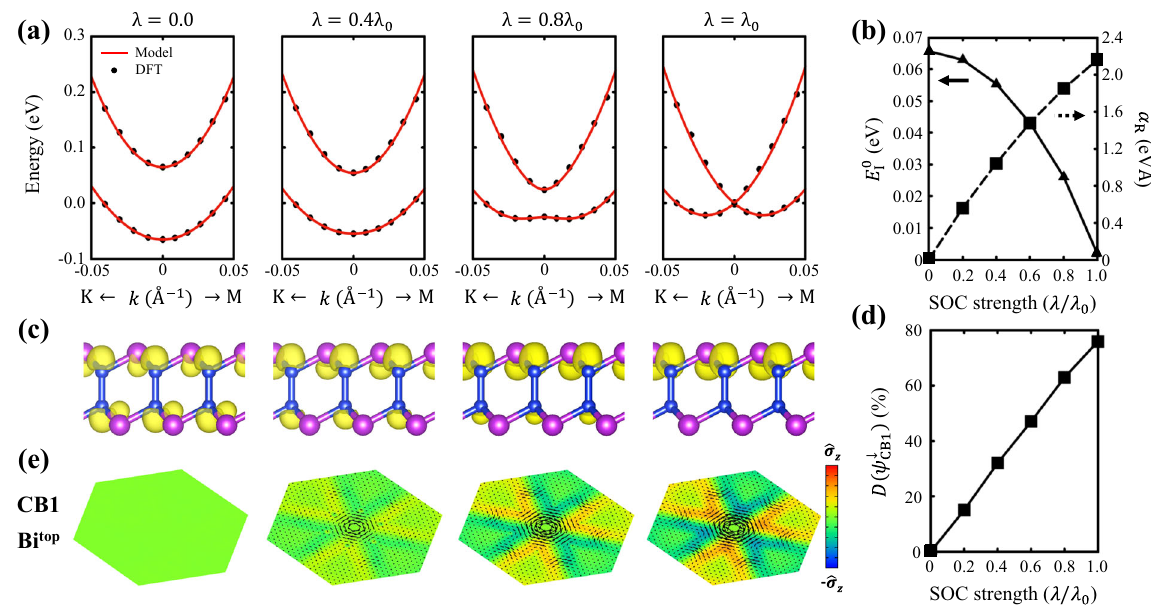
Fig. 3 Role of the spin – orbit coupling in the spin-layer locking. Evolution of the electronic structure with the SOC strength λ / λ 0 ∈ (0, 1), where λ 0 is the real SOC strength: a two lowest conduction bands near the Γ point. The black dots show the energy eigenvalues calculated by ) and the DFT, which were fi tted by the model de fi ned in Eq. (3), plotted with red solid lines. b λ -dependence of the interaction energy ( E 0 I j 2 , spin-resolved wavefunction squared, calculated at k = (0.015, 0)(2 π / a ) near the Γ point. Rashba strength ( α R ) fi tted in ( a ). c j ψ # Γ − M CB1 d Degree of wavefunction segregation D( ψ ) de fi ned in Eq. (5) evaluated from ( c ) as a function of λ . e Spatially resolved spin maps on the top Bi atom layer plotted in the fi rst Brillouin zone for the lowest conduction band. The size of black arrows and different colors indicate the in-plane and out-of-plane spin